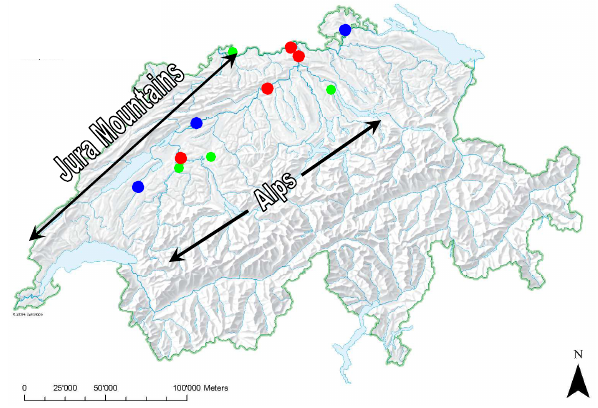
Fig. 1. CN-MET measurement network. Red dots correspond to the 4 nuclear power plants locations with surface in-situ measure- ments (from SW to NE: Mueleberg, Goesgen, Beznau, and Leib- stadt), blue dots to the three upper-air ground-based remote sensing sites with low-tropospheric wind profilers and microwave radiome- ters (from SW to NE: Payerne, Grenchen, and Schaffhausen), and green dots to in-situ measurements located on television